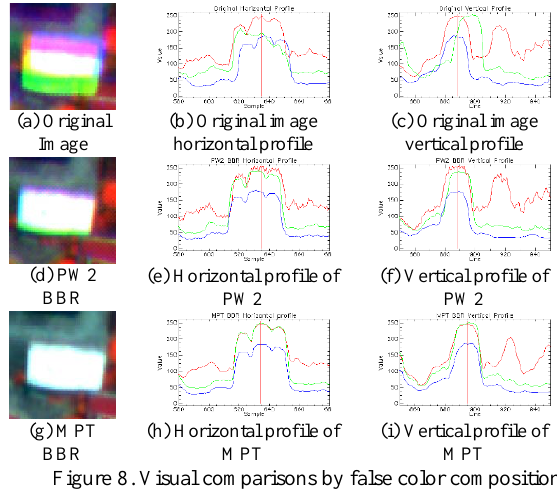
Figure 8. Visual comparisons by false color